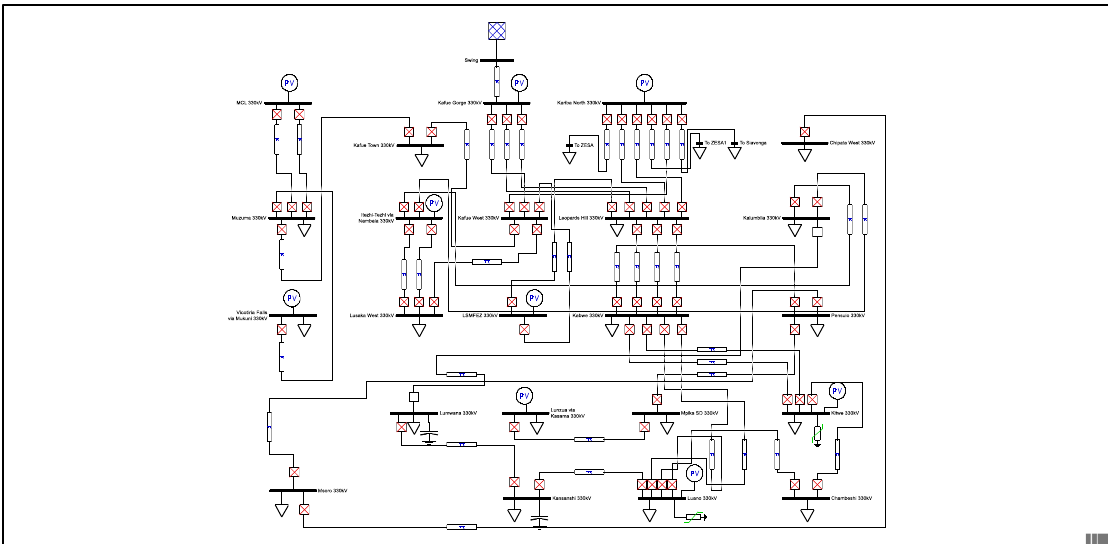
Figure A2. Layout showing the PSAT model for the existing 330 kV Zambian network.